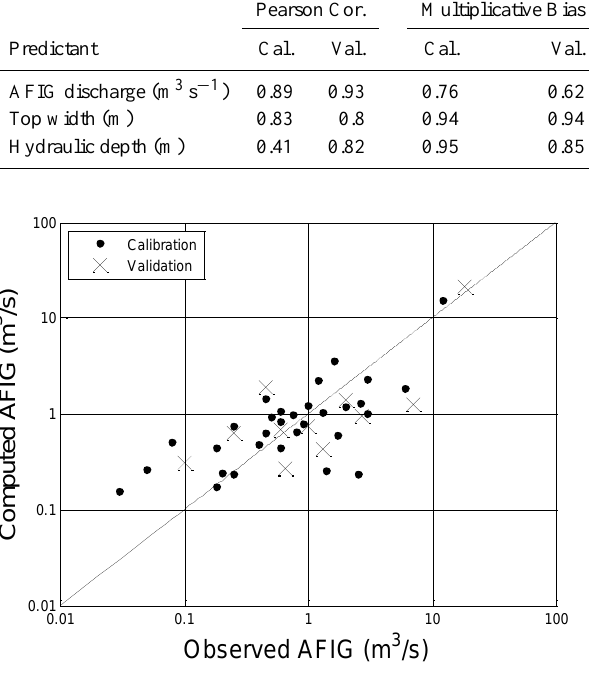
Figure 7. Observed versus computed discharge values for the calibration and validation datasets Fig. 7. Observed versus computed discharge values for the calibra- (note the final equations presented in Table 4 were derived from the full data set). The 1:1 line is tion and validation datasets (note the final equations presented in shown. Table 4 were derived from the full dataset). The 1:1 line is shown.